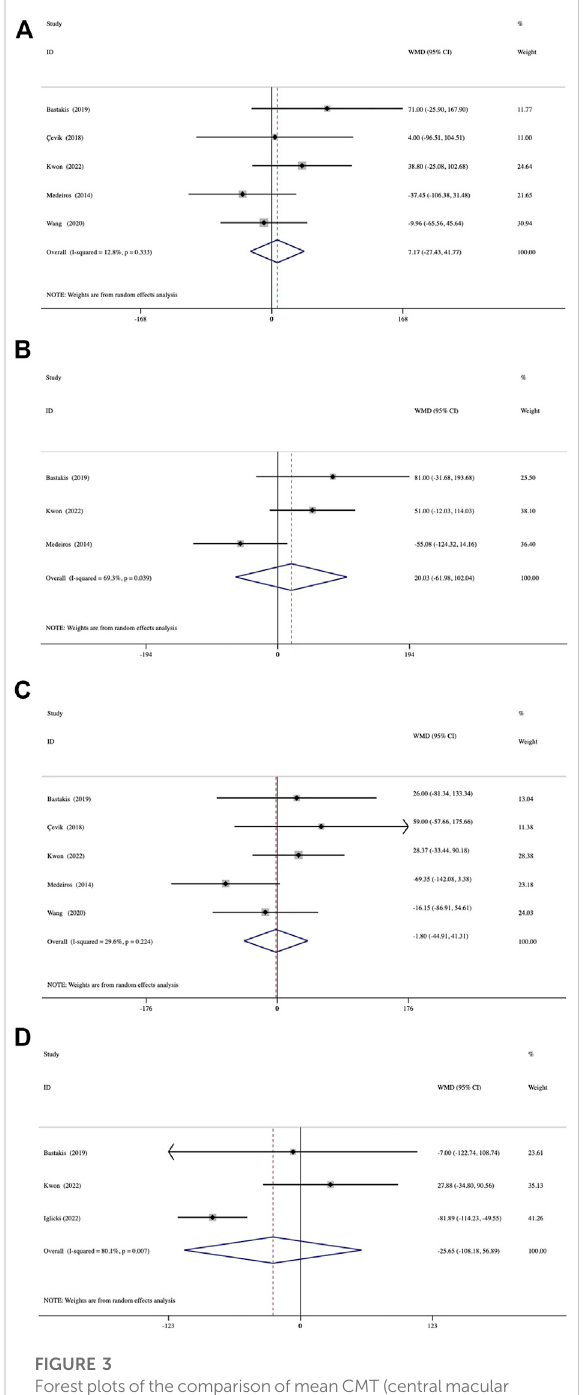
ForestplotsofthecomparisonofmeanCMT(centralmacular thickness) improvement between the vitrectomized and nonvitrectomized groups (A) 1 month, (B) 3 months, (C) 6 months, and (D) 12